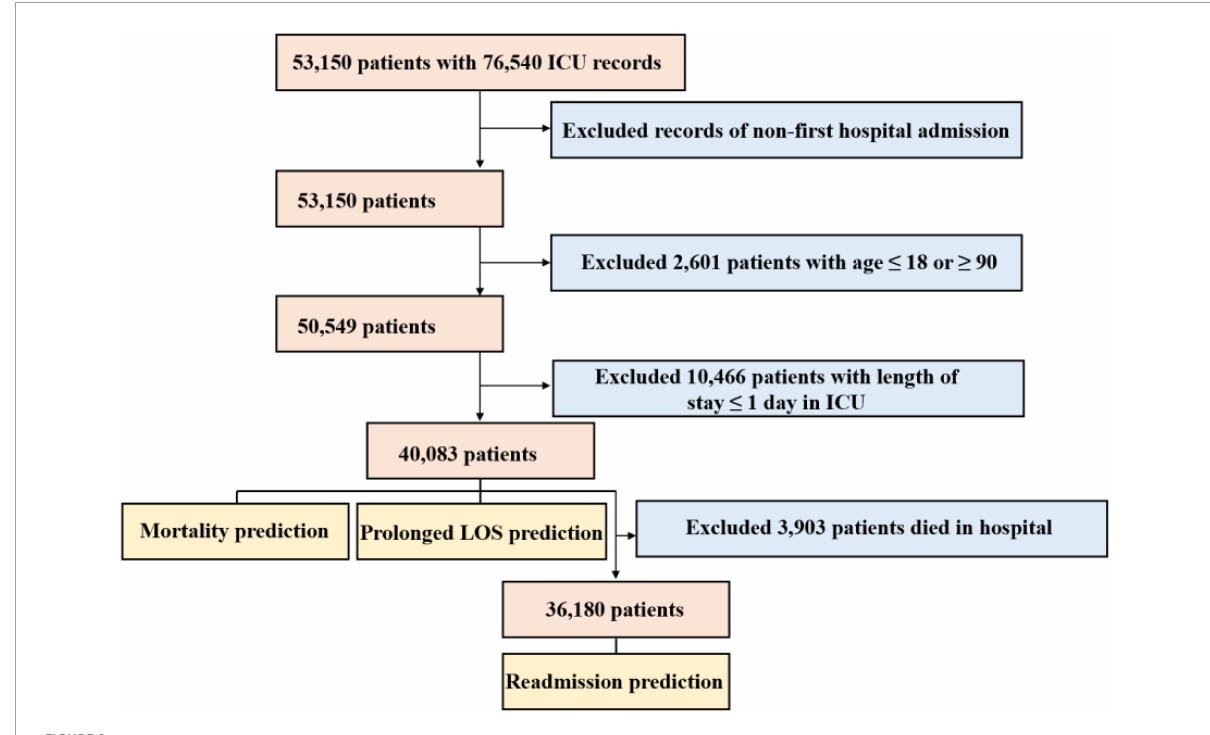
FIGURE2 Flow chart depicting the inclusion of study participants.